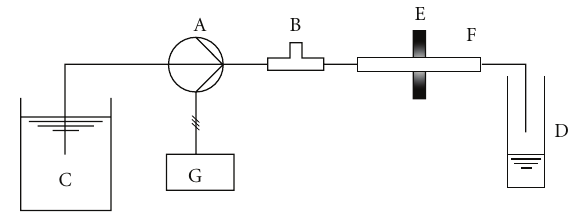
Figure 2: Schematic of the equipment simulating a circulatory vessel : A, peristaltic pump; B, injection system; C, D, beakers; E, permanent magnet; F, glass tube; G, tension